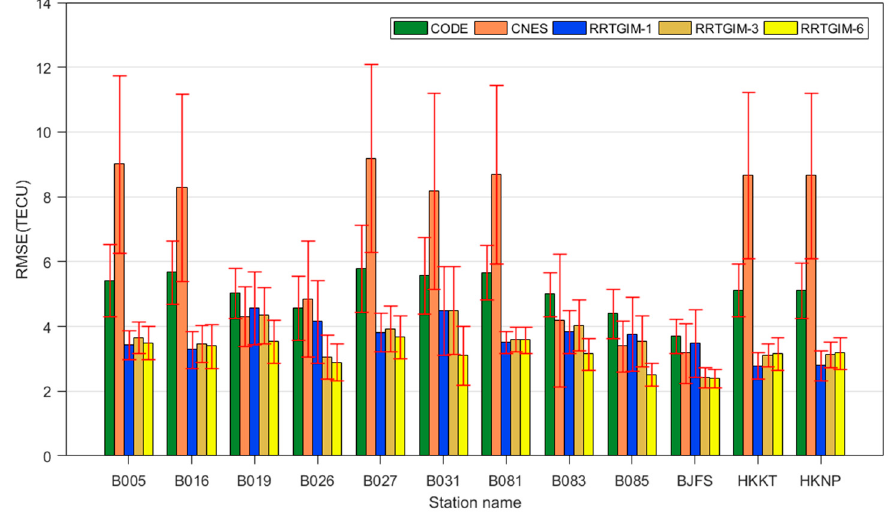
Figure 13. The average and standard deviation (STD) of STEC RMSE for 12 GNSS stations in China for DOY 78–99, 2020.